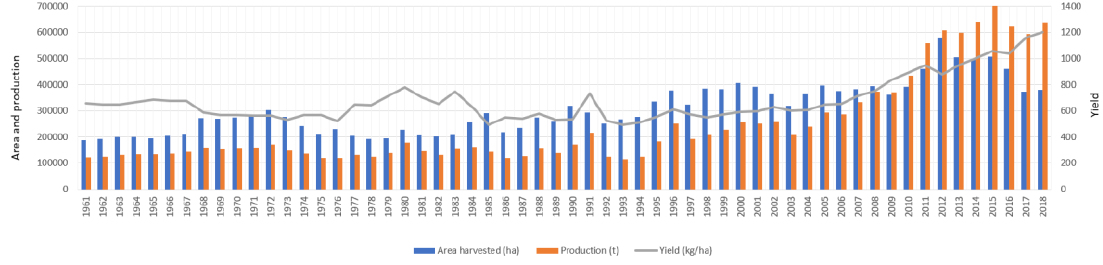
Figure 1. Chickpea area, production, and productivity trends in sub-Saharan Africa (SSA) from 1961–2018